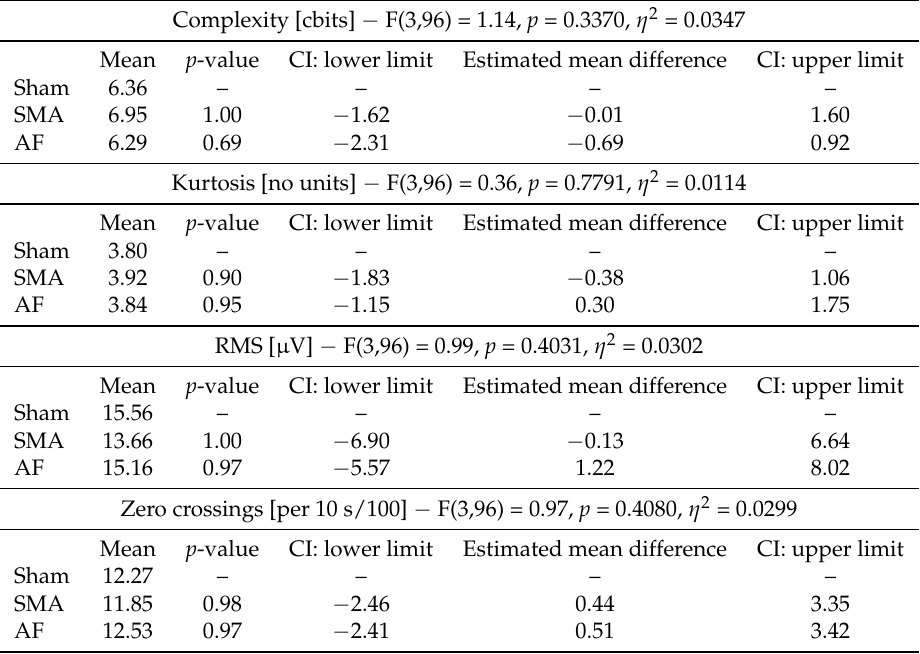
Table 1. Mean of EEG descriptive statistics: complexity, kurtosis, RMS amplitude, and zero-crossings; calculated using formulas from [39] across all 5 subjects for all 6 repetitions of protocol 1 ( n = 30 for stimulation data and n = 10 for sham data). Also shown are the p -values, estimated mean differences and lower and upper Confidence Intervals (CI) from multiple comparisons of sham data with the three reconstruction methods. One way ANOVA results are also